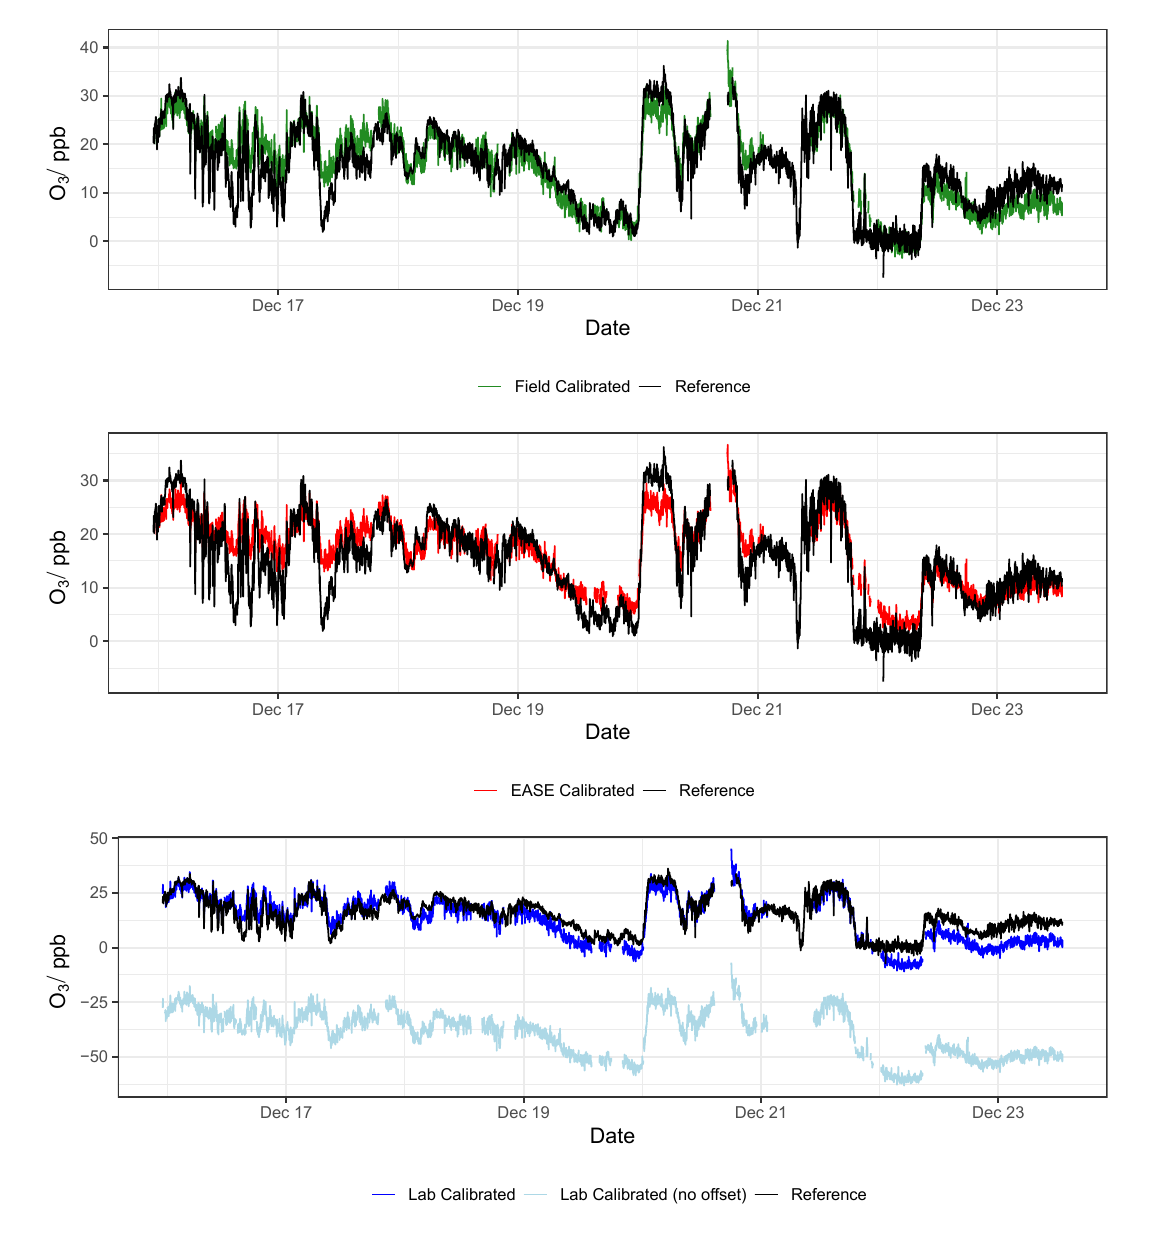
Figure 16. Example O 3 time-series from a single EC node during the validation of the different calibration methods, compared with data from the reference instrument. Lab is short for